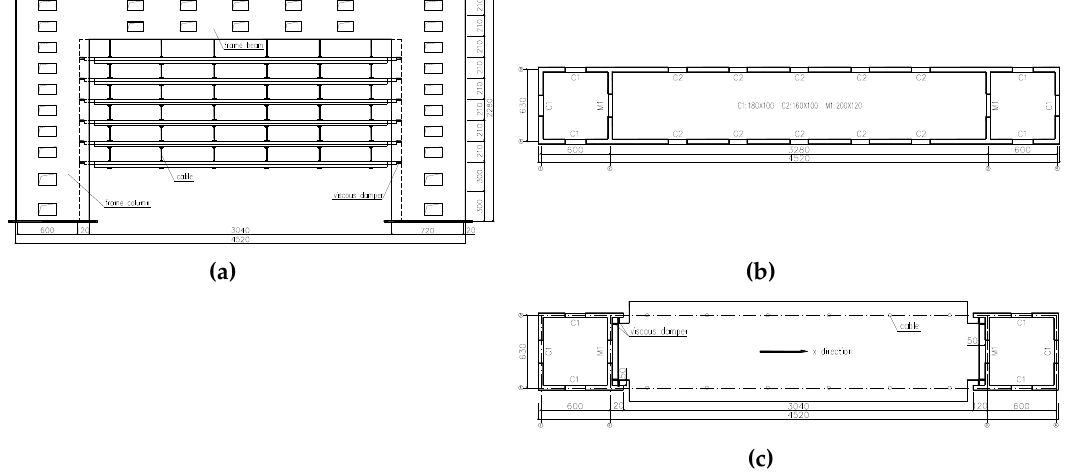
Figure 2. Schematic of structural plane and elevation. ( a ) Front view; ( b ) frame-beam floor plan; ( c ) suspended floor plan.